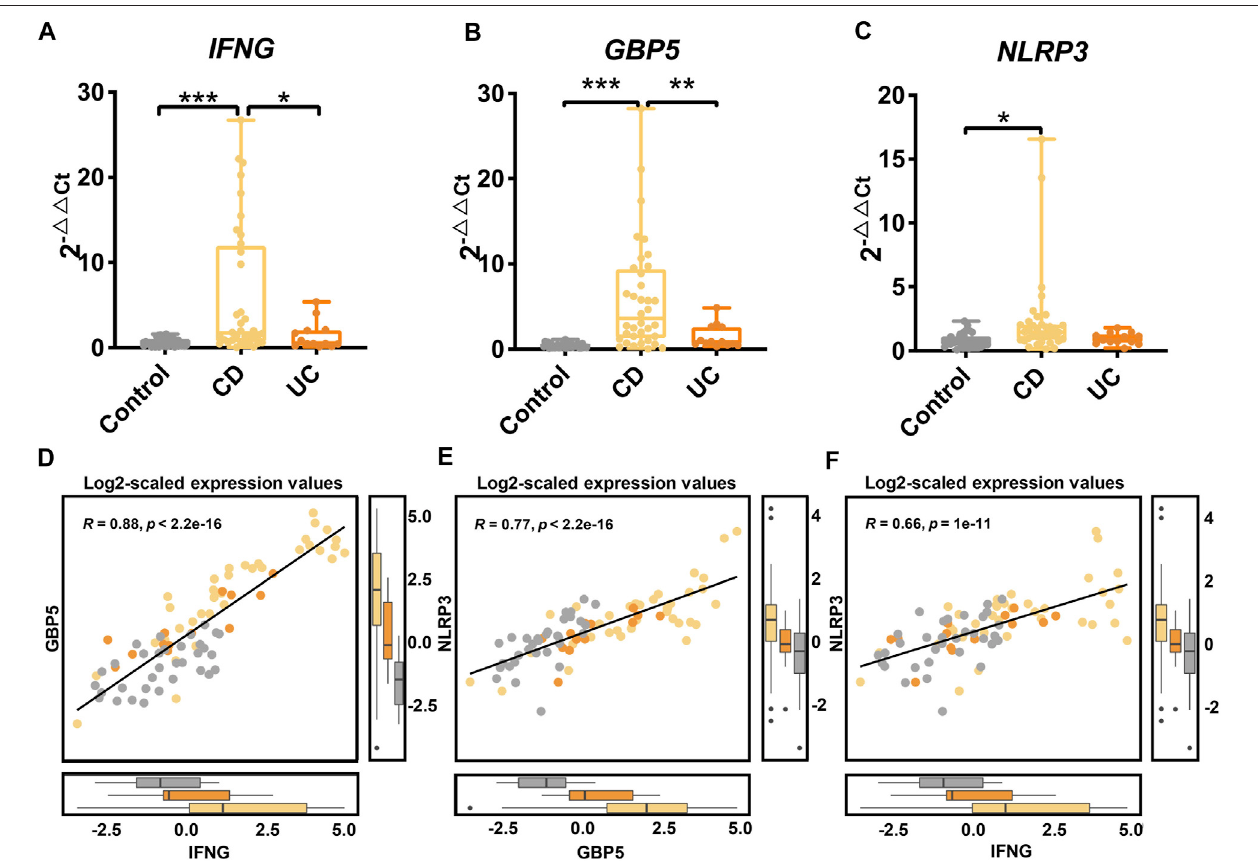
FIGURE7| Geneexpressionof IFNG , GBP5 ,and NLRP3 inanindependentcohortofhealthycontrols,CD,andUCpatientsasdeterminedbyqRT-PCR.Thegene expressionsof (A) IFNG , (B) GBP5 , and (C) NLRP3 in thecontrol, the CD,and theUCpatients.Dataarepresented asmean ±standard error. * p < 0.05, ** p < 0.01, and *** p < 0.001. N = 36, 13, and 33 for the CD, the UC, and the control groups, respectively. (D) Linear regression between IFNG and GBP5 based on log2-scaled expression values (Spearman, R = 0.88, p < 2.2e-16). (E) Linear regression between GBP5 and NLRP3 based on log2-scaled expression values (Spearman, R = 0.77, p < 2.2e-16). (F) Linear regression between IFNG and NLRP3 based on log2-scaled expression values (Spearman, R = 0.66, P =